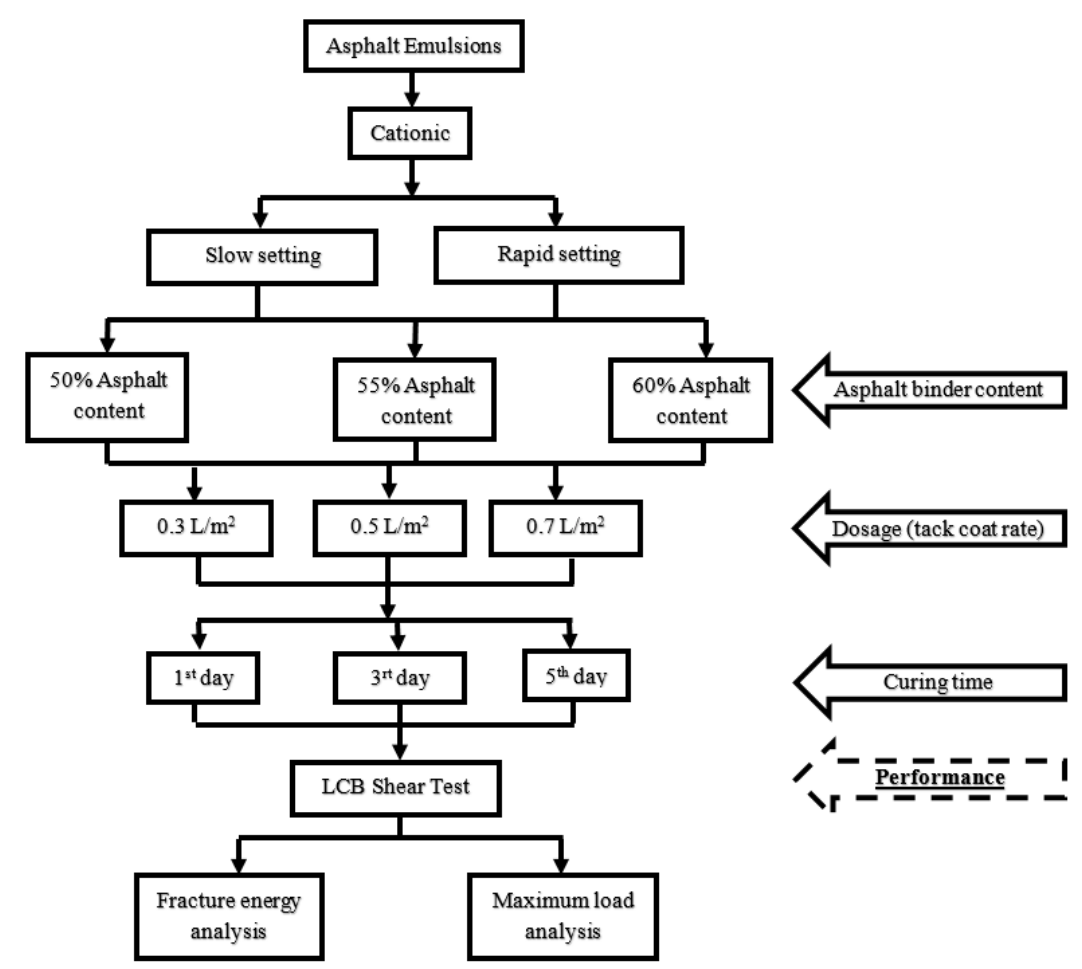
Figure 2. Methodology of the experiments.